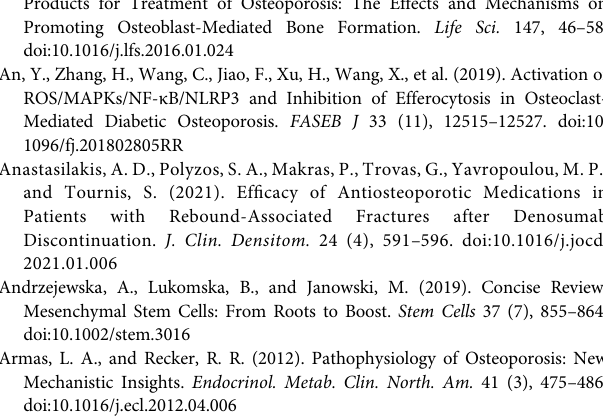
Supplementary Figure S1 | (A) Fingerprint of Eucommia extract. (B) Fingerprint of Cuscuta extract. (C) Fingerprint of Drynaria extract. Supplementary Figure S2 | Micro-CT images of femur of GIO rats. Supplementary Figure S3 | E.C.D. extracts reduced the resorption area on bone slices. (A) Representativephasecontractimagesofboneresorptionpit.Theblackarrow pointedtotheresorption pit. (B) Representativeimagesoftoluidinebluestainingofbone resorptionpit.Theblackarrowpointedtodarkbluestainingoftheresorptionpit. (C) The percentage area of bone resorption pit was assessed by Image J. n = 3 in each group. Data was analyzed as mean ± SEM, * vs. CTRL group, † vs. +C/R group, P < 0.05. Supplementary Figure S4 | (A,C,E) Western blot images of PI3K, GAPDH, p-Akt, Akt, p-P38, and P38. (B,D,F) Quantitative protein expression of PI3K, p-Akt, and p-P38. n =3ineachgroup.Datawasanalyzed asmean±SEM,*vs.CTRLgroup, † vs. +C/R group, P <